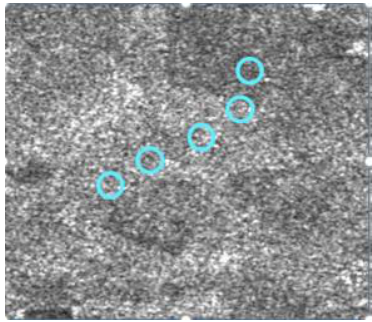
Figure 14 . Ground truth spots of windmills on a VV-polarised